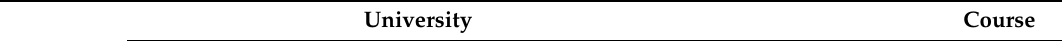
Table 5. Vaccine attitude questionnaire score